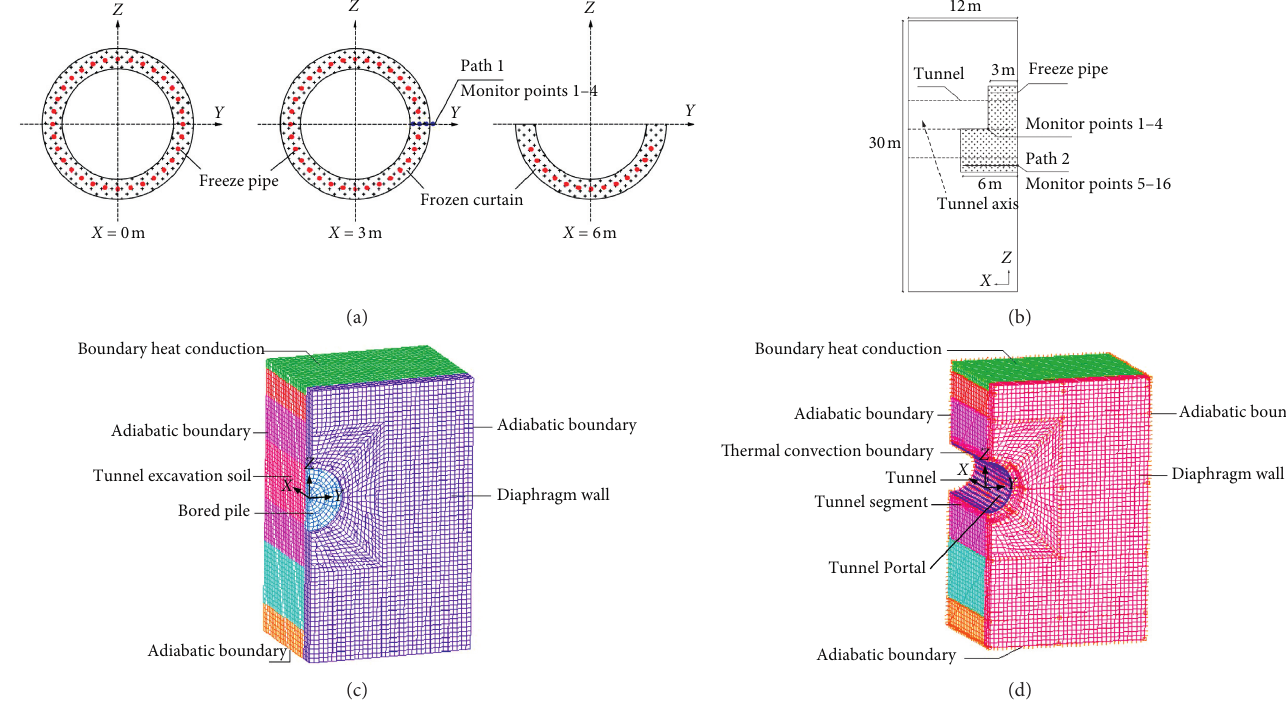
Figure 2: Schematics of finite element model: (a) cross-sectional views of shield tunnel; (b) section y � 0; (c) 3D model for the horizontal freezing process; (d) 3D model for the natural thawing process. Notes: in Figure 2(a) from left to right, the monitor points are in the sequence of 1, 2, 3, and 4; in Figure 2(b) from right to left, the monitor points are in the sequence from 5 to